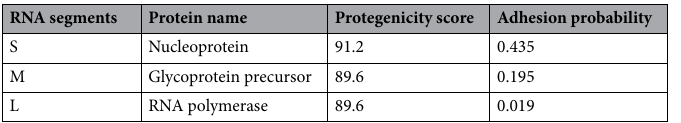
Table 1. Protegenicity score and adhesion probability score of RNA segments of